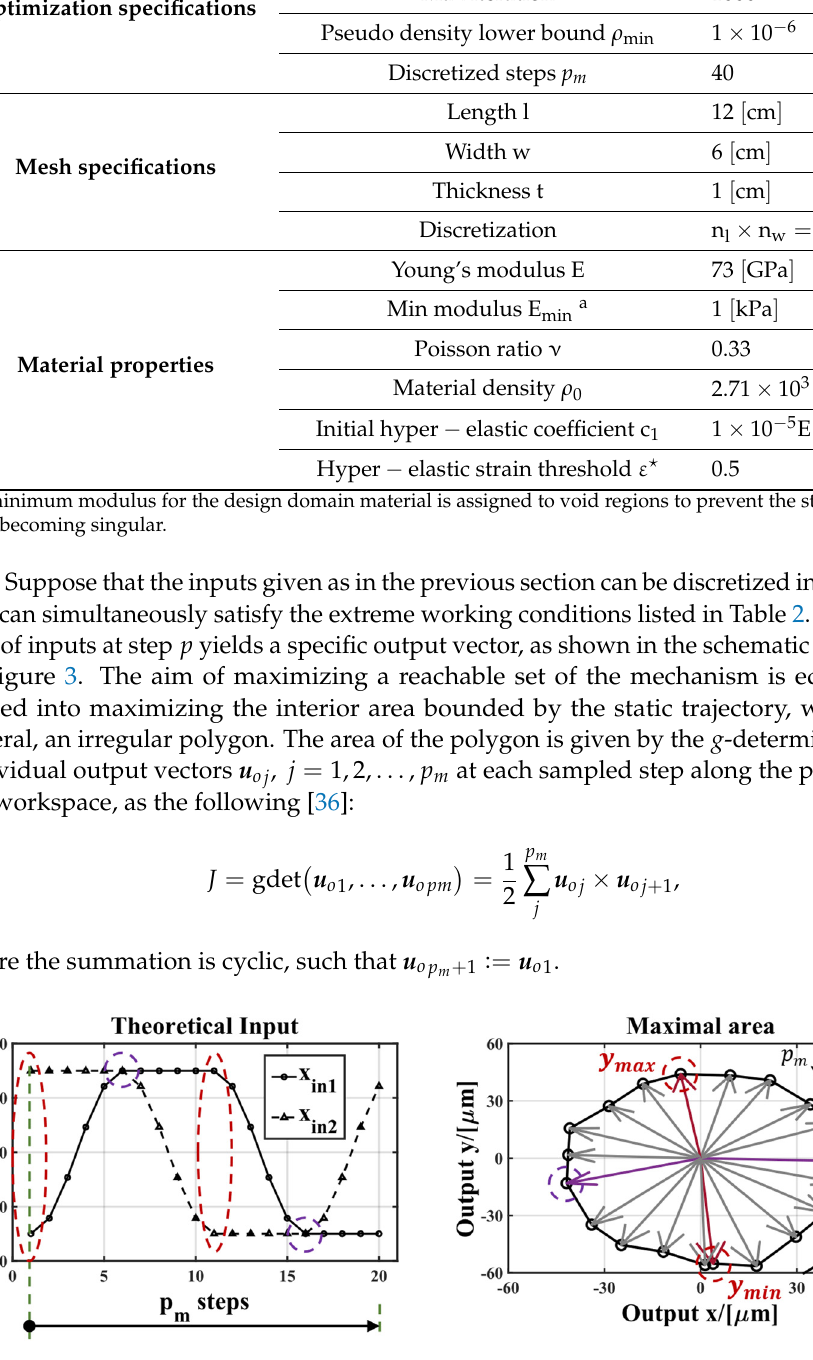
Table 3. Algorithm and material specifications for the TO method.